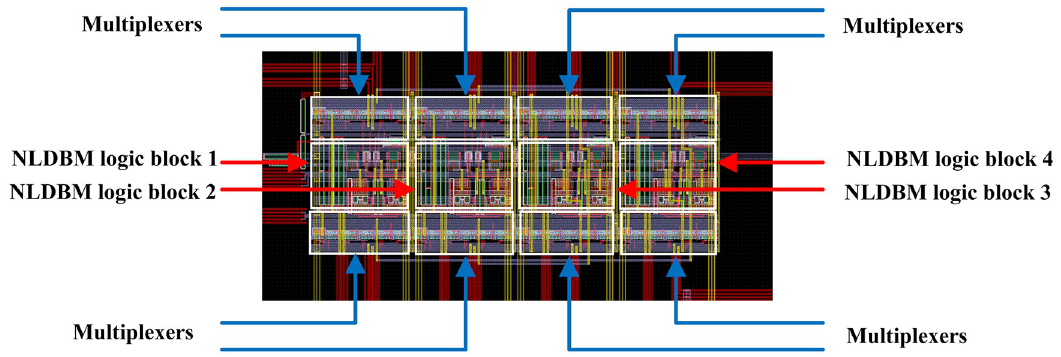
Fig 3. The designed layout. 4 NLDBM logic blocks and 8 multiplexers are